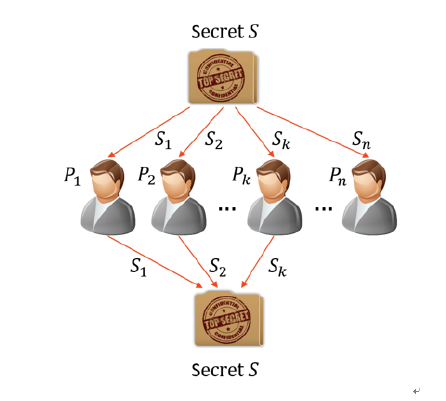
Figure 1. Shamir’s secret sharing scheme.